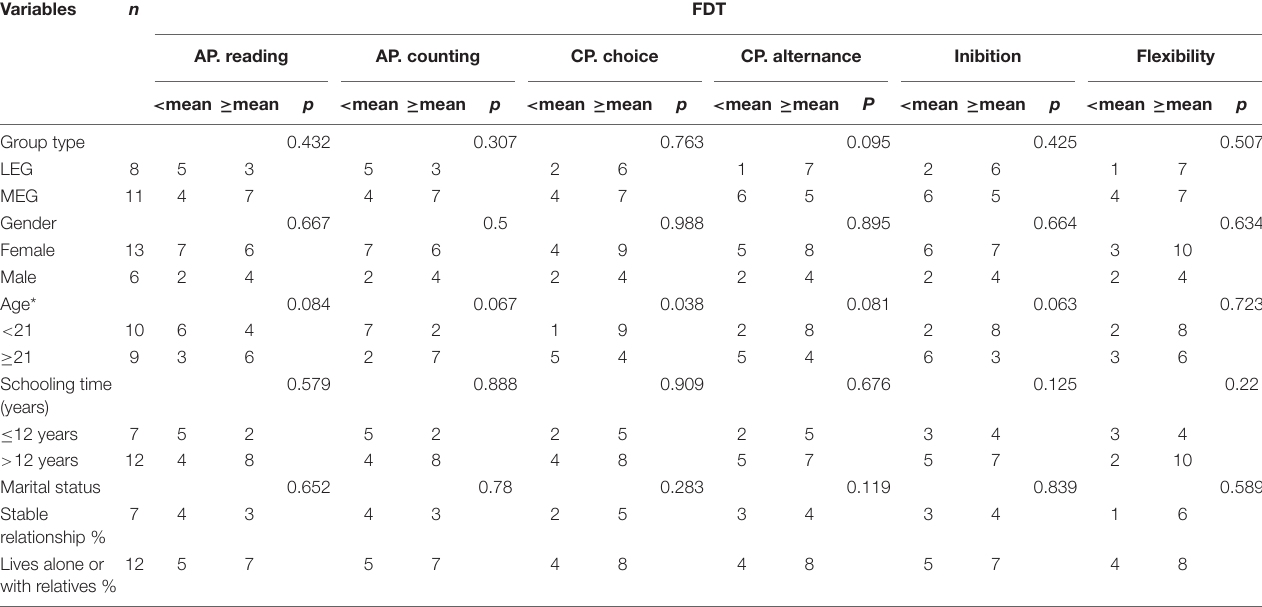
TABLE 4 | Performances in five digit test (FDT) test with respect to group and socio-demographic variables in subjects practicing trance mediumship. Variables n FDT AP. reading AP. counting CP. choice CP.